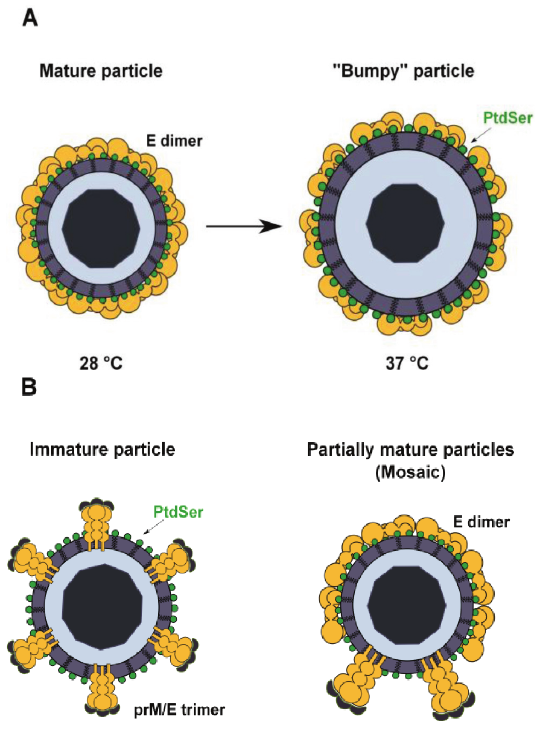
Figure 4. Possible mechanisms of PtdSer exposure in flavivirus virions. ( A ) Flavivirus particles produced in mosquito cells at 28 °C have a closed herringbone smooth conformation that protects the lipid envelope from the external medium. Upon an increase in temperature, particles expand and adopt a “bumpy” conformation that renders virion -associated PtdSer accessible. At 37 °C, the human body temperature, almost all virions present this conformation; ( B ) Inefficient cleavage of prM by cellular furin leads to the release of immature or partially mature (mosaic) virions in wich the lipid envelope is exposed to the external medium. Virion-associated PtdSer could therefore be accessible to TIM and TAM